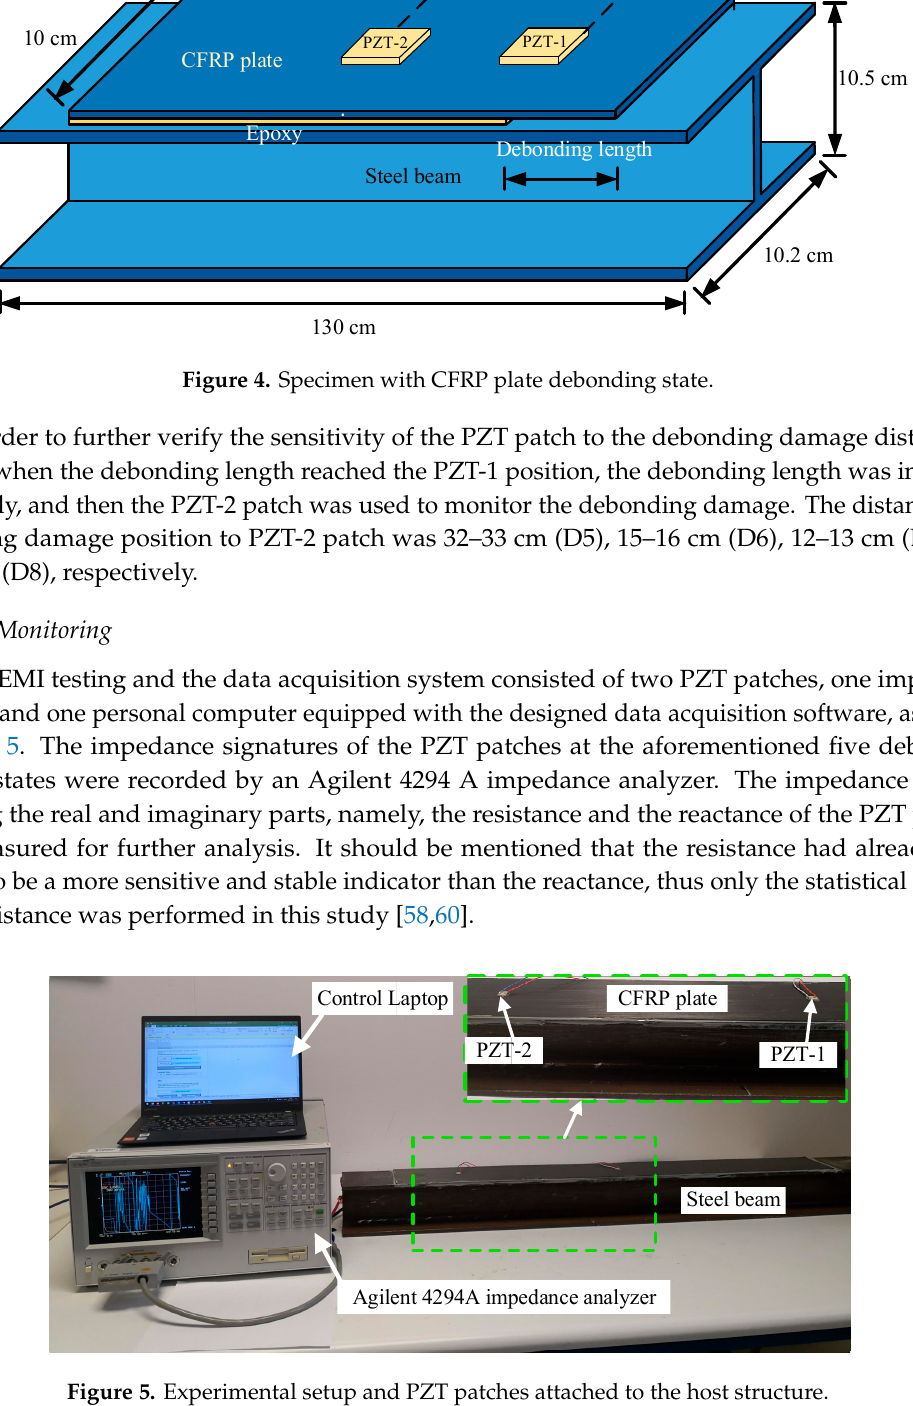
Figure 5. Experimental setup and PZT patches attached to the host structure.